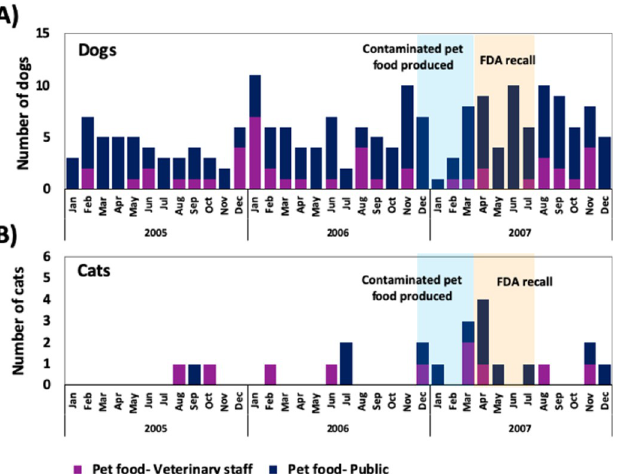
Fig 3. Number of dogs and cats exposed to pet food products, by call source, as reported to the APCC during toxicological consult calls from 2005 to 2007, inclusive. (A) Number of dogs. (B) Number of cats.